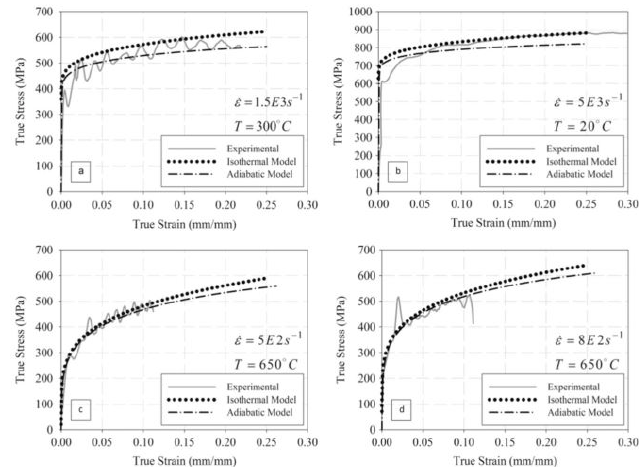
Figure 37. Comparison of experimental and simulation results for adiabatic and isobaric conditions for as-received material at ( a ) 1.5 × 10 3 s − 1 at 300 °C and ( b ) 5 × 10 3 s − 1 at 300 °C and for the heat treated material at ( c ) 5 × 10 2 s − 1 at 6500 °C and ( d ) 8 × 10 2 s − 1 at 650 °C [224] .